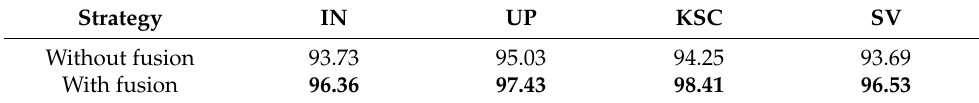
Table 10. Effective analysis of the attention blocks fusion strategy (OA%).